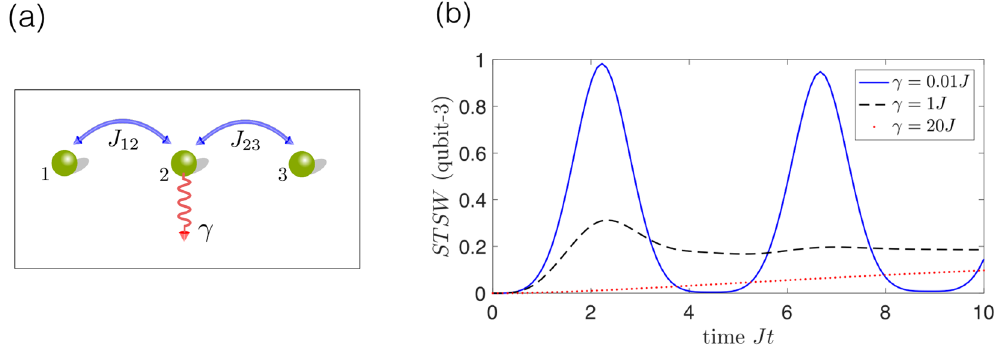
Figure 2. The STS weight versus time in a simple quantum network model described in example 1 in the text. ( a ) Three identical qubits, with coherent coupling J 12 ( J 23 ) between qubit 1 (2) and 2 (3). To simulate the damaged node, we assume qubit 2 suffers a phase damping γ . ( b ) The blue-solid, black-dashed, and red-dotted ST curves show the STS weight ( ST SW ) of the assemblage σ t { ( )} of qubit-3 for different dephasing rates of the a x a x , middle qubit γ / J = 0.01, 1, and 20, respectively. The measurement settings { x } on qubit-1 at time 0 are the Pauli set X , Y , and Z . The initial condition is ⊗ ⊗ 1 0 0 , and = ≡ J J J . The time t is in units of J − 1 . From the 12 23 figure, we can see that when the dephasing rate increases from 0.01 J to 1 J , the amplitude of the ST SW decreases. This means that when dephasing rate increases from 1 J to 20 J , the dephasing mechanism dominates the dynamics of the system, leading to a disappearance of the oscillatory behavior. Although the dephasing rate is large (e.g., the red-dotted curve), the effect of the measurement on qubit-1 at time 0 can still be transited to qubit-3 via the coherent coupling between the qubits, making the ST SW gradually increase. For brevity, we are omitting analogous plots for the STS robustness.